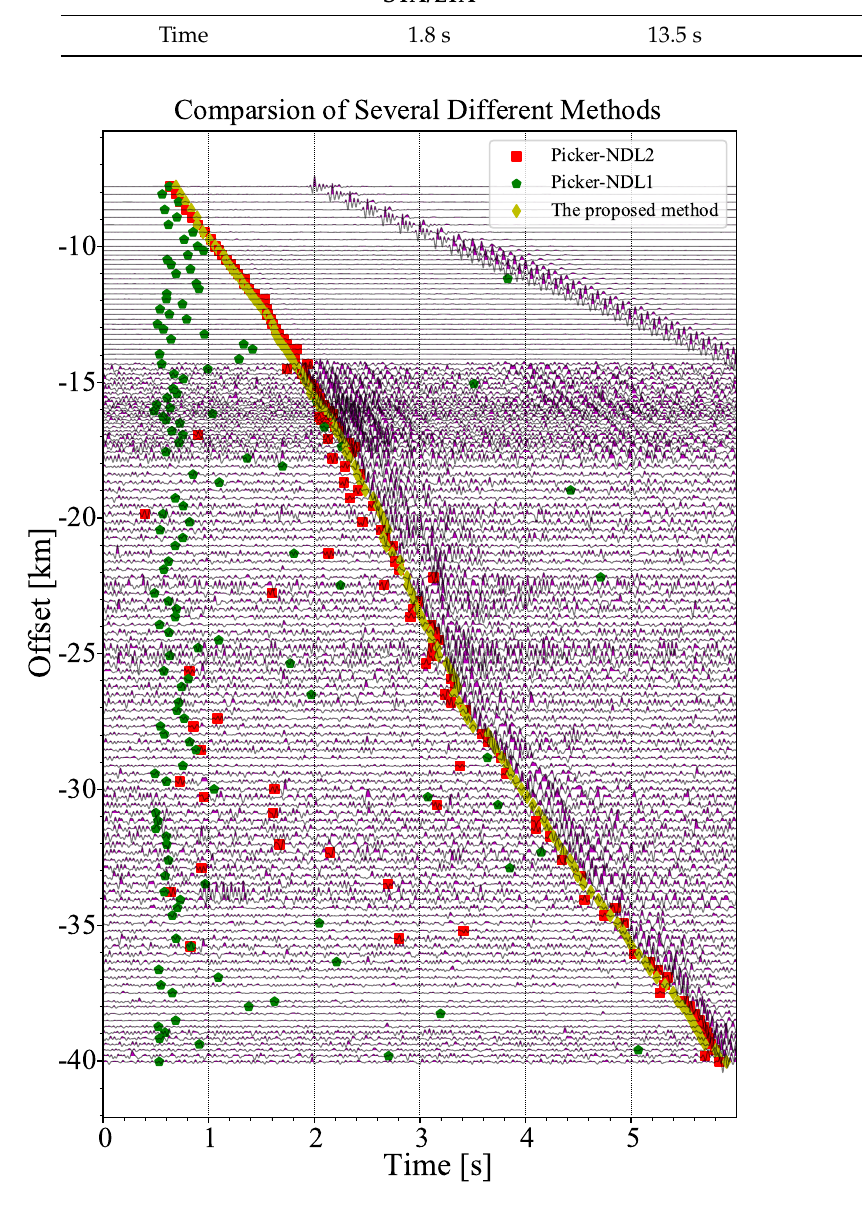
Figure 13. Comparison of the results of the proposed method and the typical NDL algorithms. Picker-NDL1 and Picker-NDL2 denote multi-band STA/LTA and AR-AIC method, respectively. The arrivals denoted by the proposed method are the same as arrivals Lag 5 in Figure 9a. All seismograms displayed are filtered by 2 30 Hz ∼